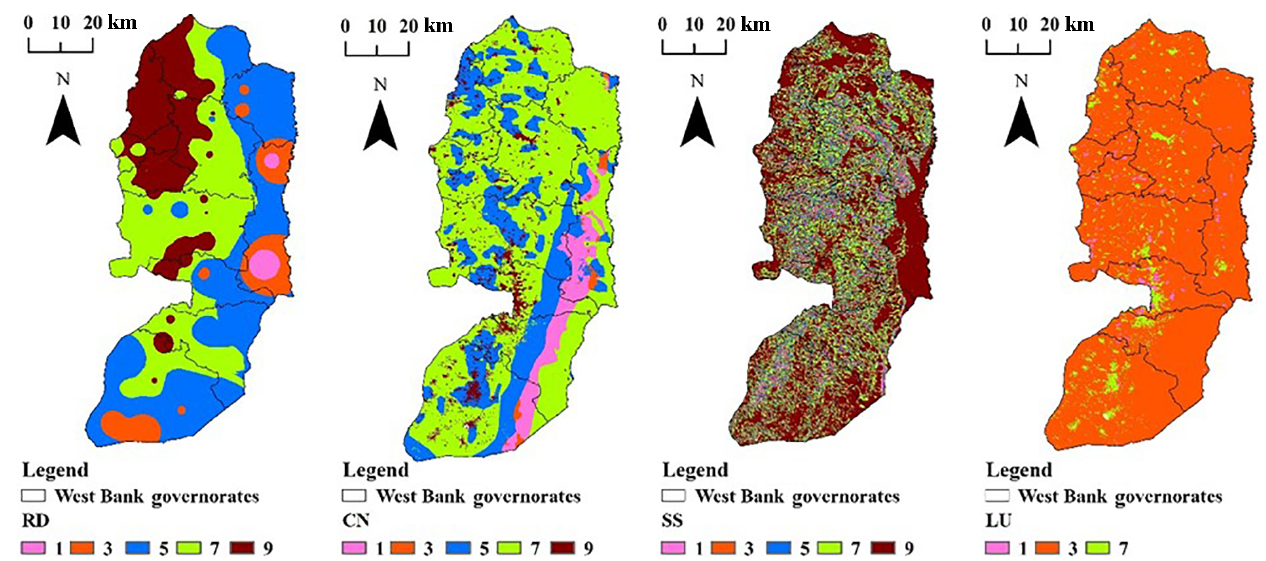
Figure 4. The score rasters of the four DRWHS criteria for the West